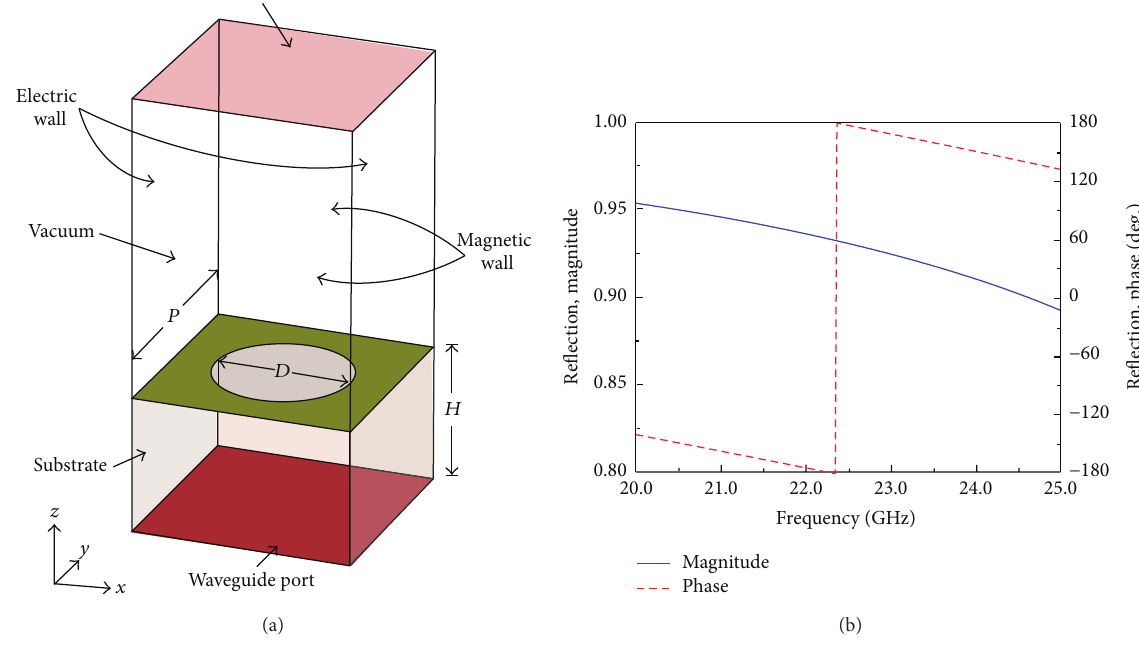
Figure 2: Reflection characteristics of the cavity under normal incidence using a unit cell